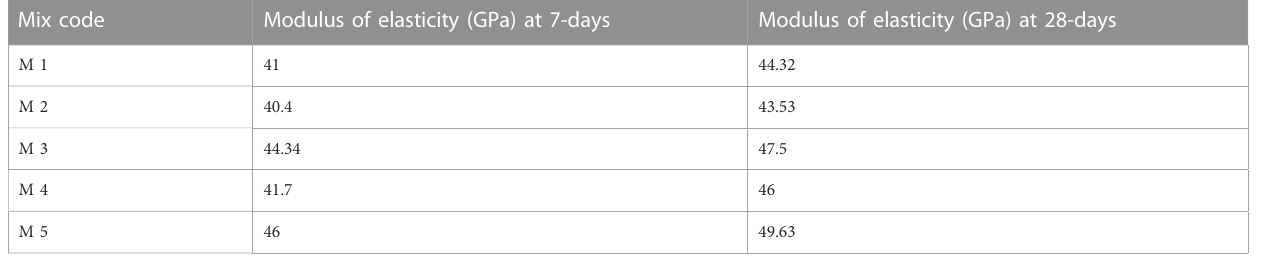
TABLE 10 Results for modulus of elasticity test. Mix code